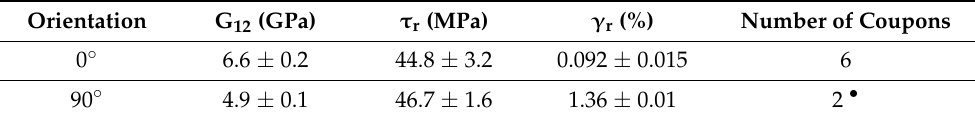
Table 3. Mechanical properties for the shear coupons for the two orientations.